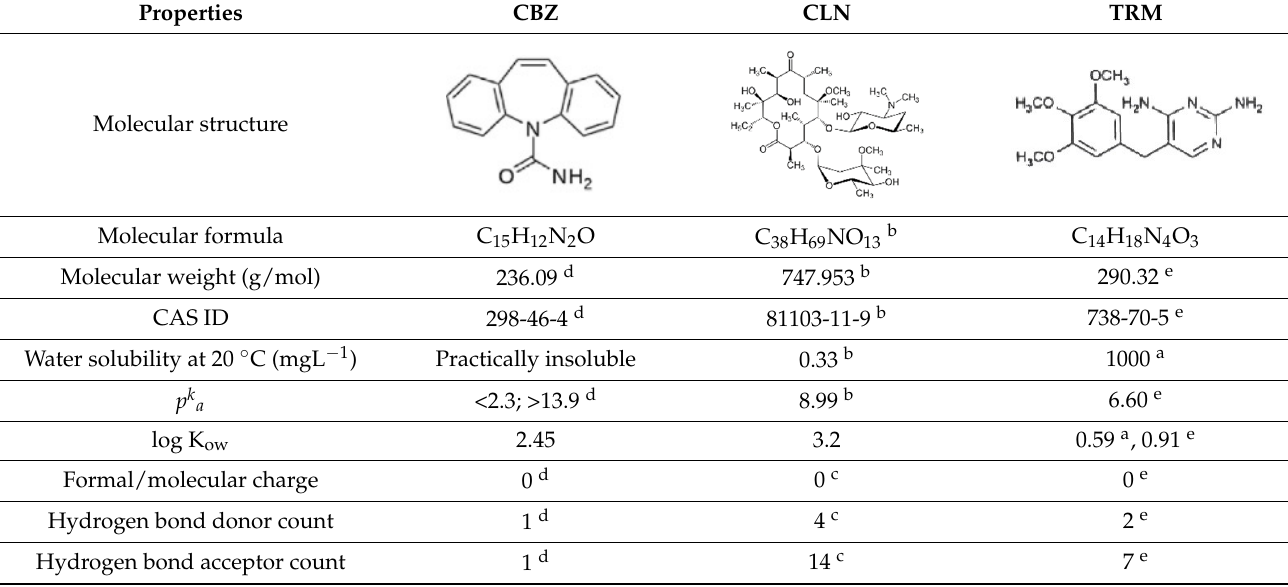
Table 2. Physicochemical properties of the pharmaceuticals used in this study.